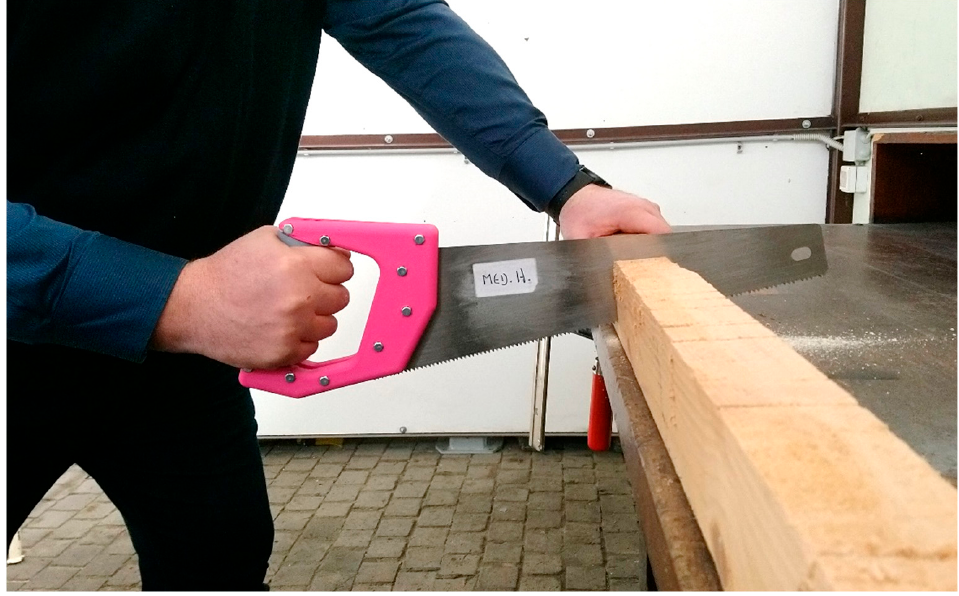
Figure 4. Sawing task.